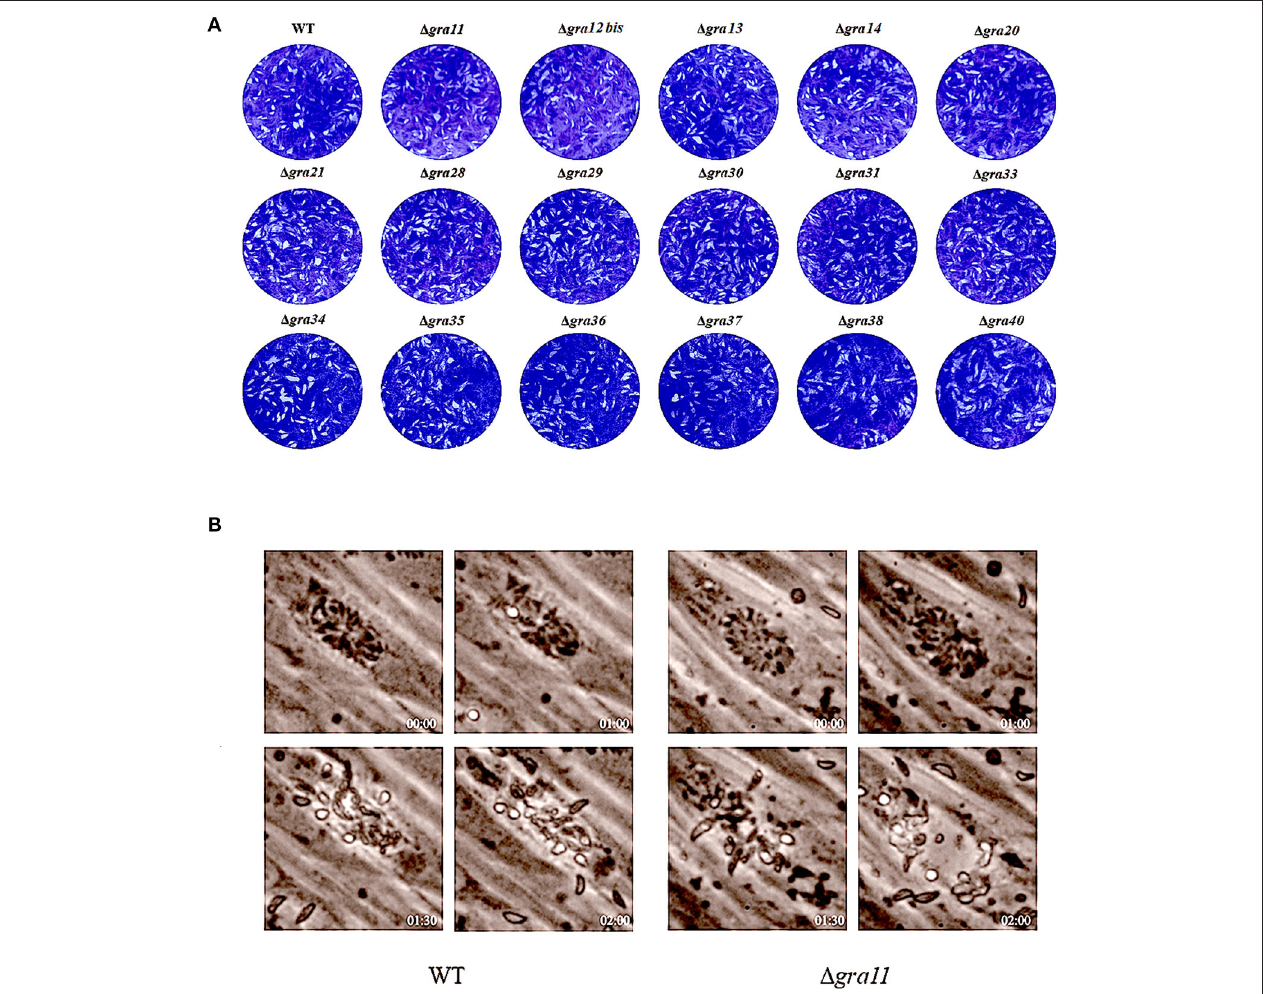
FIGURE 2 | Phenotypic characterization of GRA Knockouts in vitro. (A) Two hundred freshly harvested T. gondii tachyzoites of WT RH strains and GRA -deficient RH strains per well were added to monolayers of HFF cells in 6-well culture plates. After 7 days, the number of plaques caused by the parasite’s proliferation was counted using a microscope. No differences were detected in the number of plaques produced by wild-type (WT) RH strain vs. any of the GRA knockout strains. (B) Representative images show the parasite egress of the parental WT RH strain and one of the GRA mutant RH strains ( 1 gra11 ). Live cell imaging showed a similar egress pattern between WT and all mutant parasites after addition of 3 µ M calcium ionophore A23187 at the indicated time points.